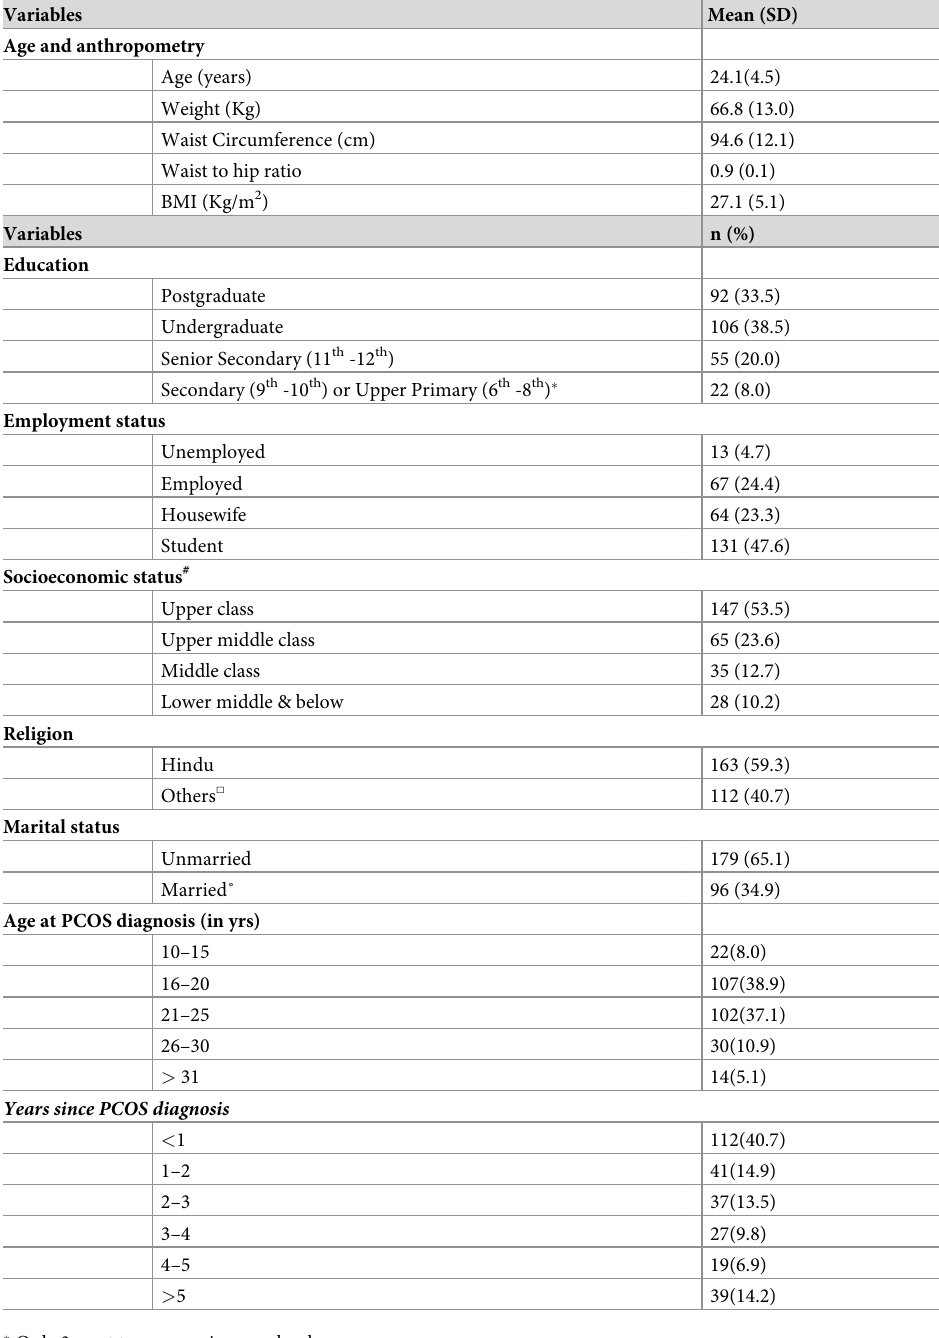
Table 1. Socio-demographic profile, age at PCOS diagnosis and duration of PCOS diagnosis of the respondents (n =